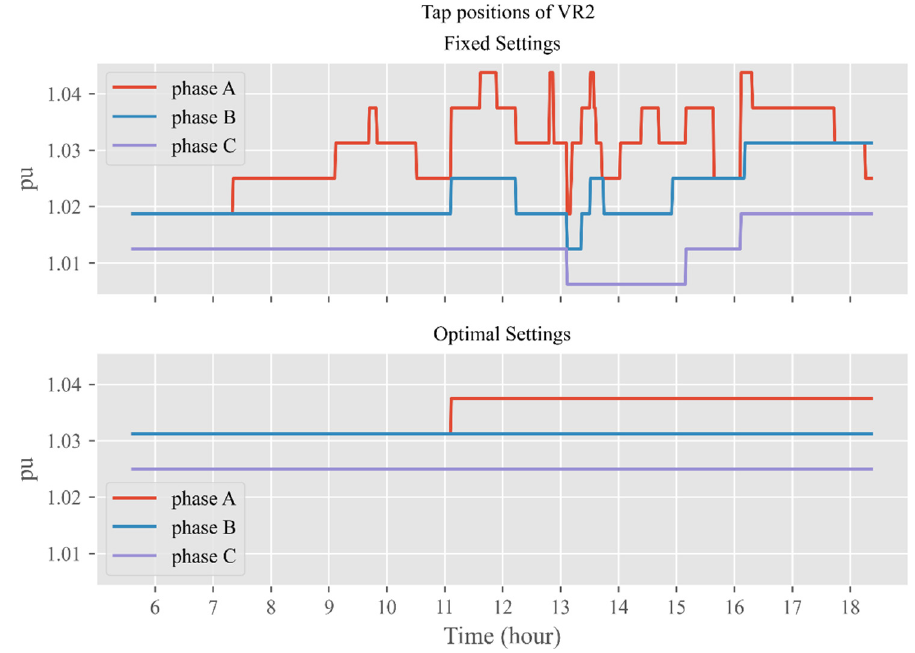
Figure 14. Three-phase tap positions of VR2.